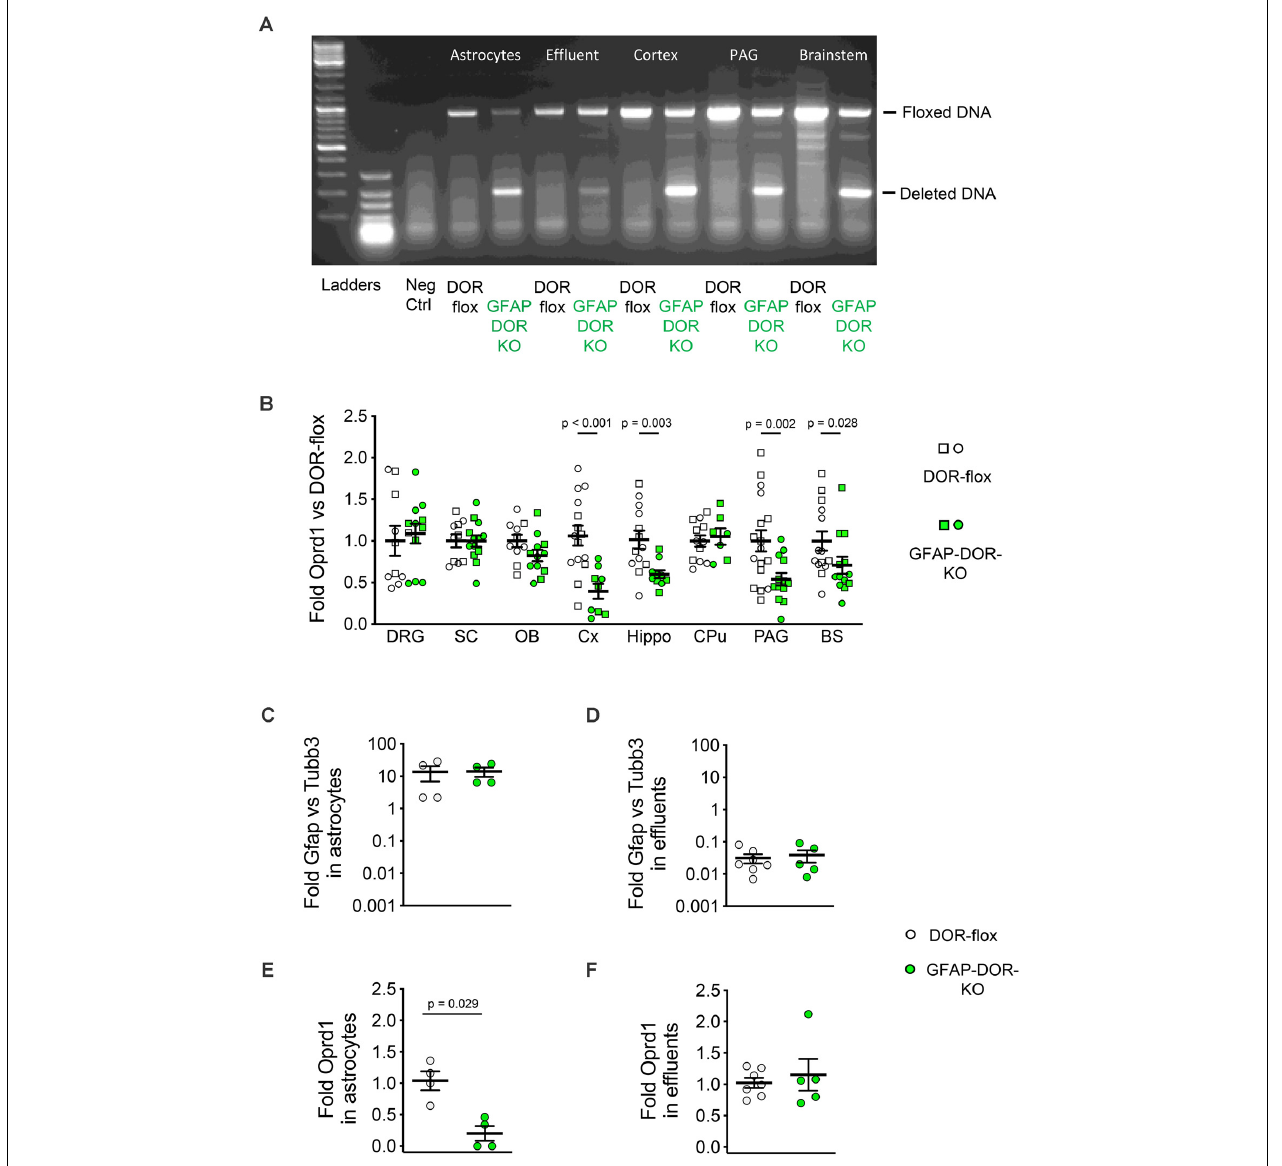
FIGURE 1 | Characterization of the GFAP-DOR-KO mouse model for astrocyte-specific deletion of Oprd1. (A) PCR on genomic DNA shows the deletion of the floxed Oprd1 (DOR) gene brain from GFAP-DOR-KO mice and no deletion in the brain from control DOR-flox mice. (B) RT-qPCR analysis shows reduced Oprd1 expression in the cortex (Cx), hippocampus (Hippo), periacqueductal gray (PAG), and brainstem (BS) of GFAP-DOR-KO animals. DRG, Dorsal root ganglia; SC, spinal cord; OB, olfactory bulb, CPu, caudate-putamen. mRNA expression was normalized to DOR-flox controls. n = 10–17 per genotype, circles for females and squares for males. Sex-grouped GFAP-DOR-KO and control DOR-flox mice were compared by Mann-Whitney analysis. P -values for the difference between genotypes are shown when significant ( p < 0.05). (C) Gfap expression was 14-fold higher than Tubb3 expression in the purified astrocytes. (D) Gfap expression was 30-fold lower than Tubb3 expression in the effluent from the ACSA-2 beads. (E) Oprd1 expression was significantly reduced in purified astrocytes from GFAP-DOR-KO mice as compared to DOR-flox mice. Mann-Whitney test, P -value indicates a genotype difference. (F) Oprd1 expression is comparable in ACSA-2 beads effluents from GFAP-DOR-KO and DOR-flox mice. Mann-Whitney test. Means ± SEM are shown. See also Supplementary Table 1 for